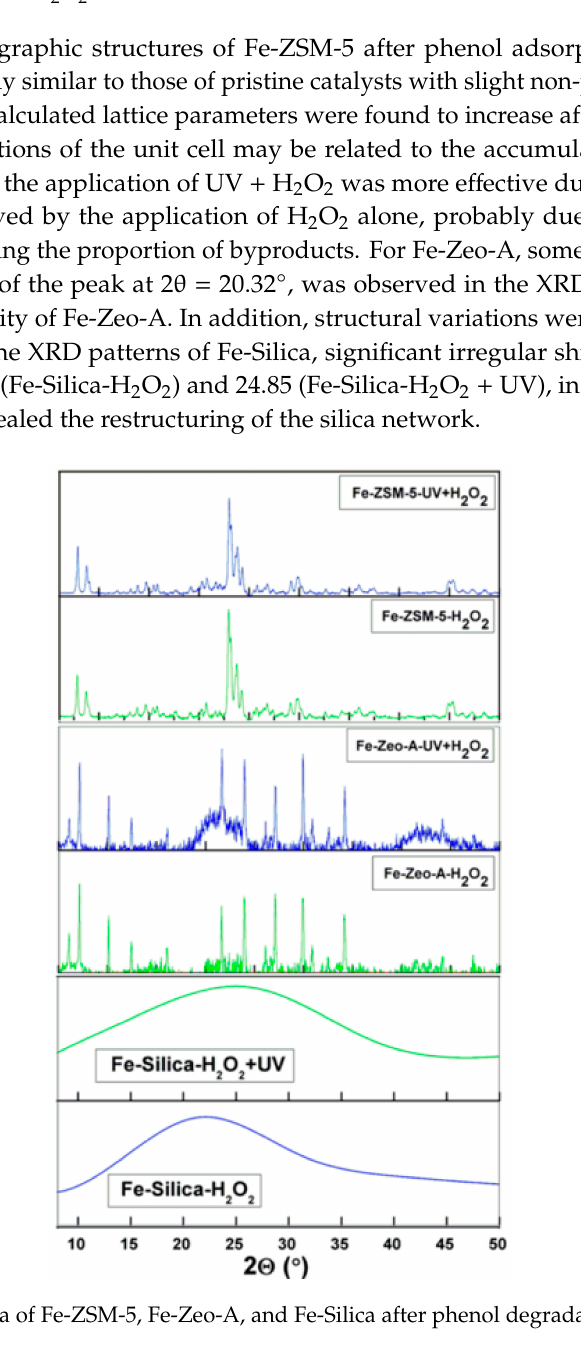
Figure 9. Transmission electron microscopy (TEM) images of Fe-ZSM-5, Fe-Zeo-A, and Fe-Silica after phenol degradation with H 2 O 2 + UV.